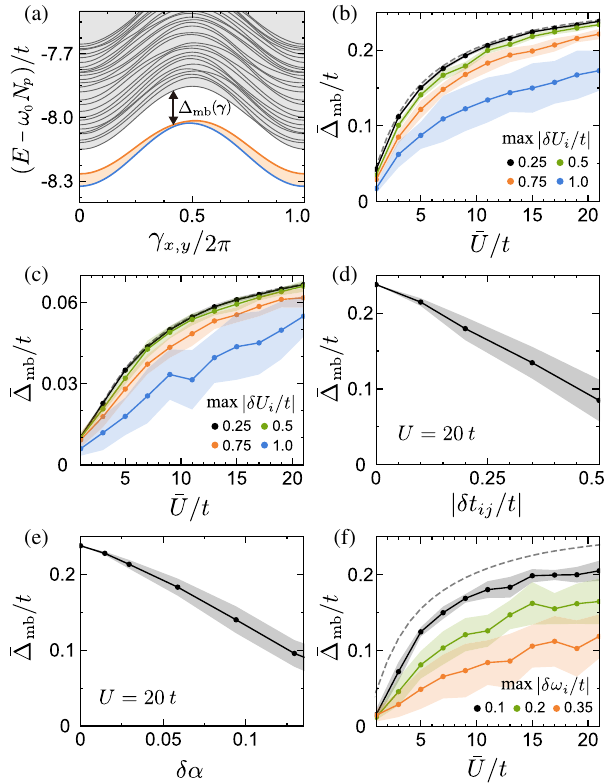
FIG. 5. (a) Spectral flow of a of the lowest 30 many-body γ γ , γ ∈ ½ 0 ; 2 π (cid:3) is inserted into eigenstates as a flux γ x ¼ y ¼ H . Weak disorder is included that visually splits the numeri- eff ; mb cally exact twofold degeneracy of the ground state manifold in the clean limit. For all flux, the GSM (orange and blue lines) remains gapped relative to the (shaded gray) excited states. Provided this gap remains in the presence of disorder, a many- body Chern number can be defined. The disorder-averaged ¯ Δ minimum value of this gap is denoted . This is used as a mb ¯ Δ metric to test sensitivity to various types of disorder. (b) as a mb ¯ U function of the average interaction strength for various strengths of interaction disorder δ U . The many-body gap is i not significantly suppressed at large interaction strengths. (c) Same as (b), but all ferrite sites are made noninteracting. ¯ Δ This comes at the cost of a drop of by a factor of about 4. mb (d) Effect of disorder in the magnitude of the tunneling strength j δ t ij j , in a strongly interacting case ( U i ¼ 20 ). (e) Effect of disorder in the flux δα through each plaquette. (f) Effect of disorder δω in the frequency of the on-site eigenmode near ω 0 . i All error bars (shaded regions) are standard errors of the mean for about 30 realizations of the disorder; the disorders δ U , j δ t , i ij j are uniformly distributed, whereas δα is the half width at and δω i half maximum of a Gaussian